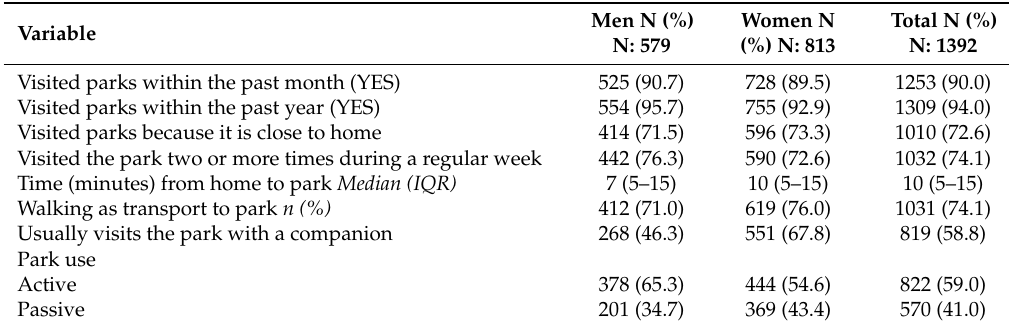
Table 2. Characteristics of the visit to the park by the park users (N = 1392).